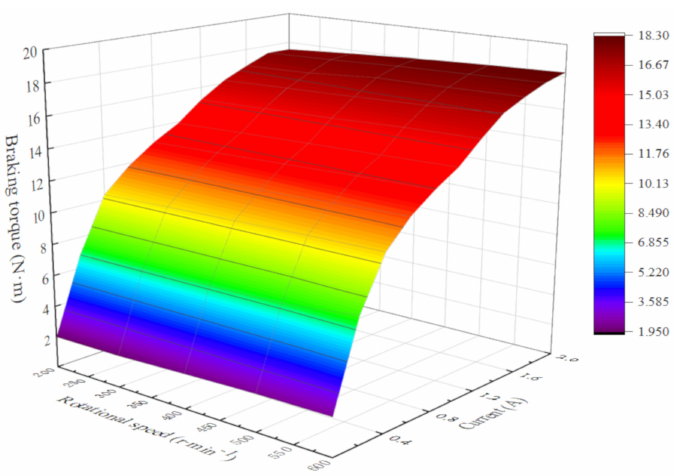
Figure 15. Dynamic variation of braking torque under different currents and rotational